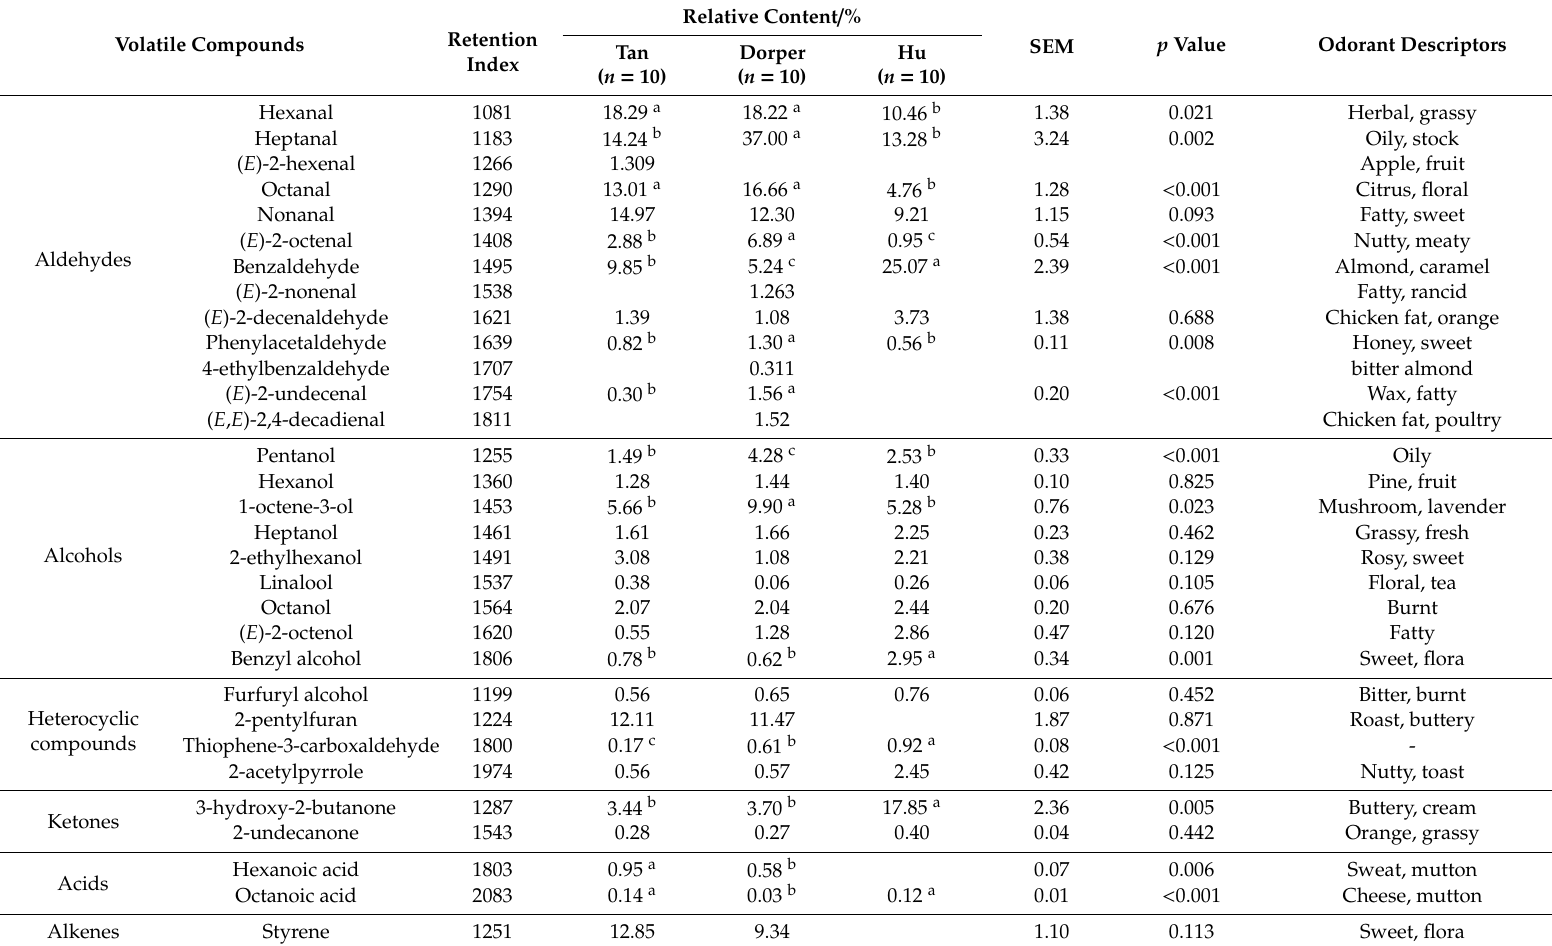
Table 7. E ff ect of breed on major Odor-Active Volatile Compounds of Cooked